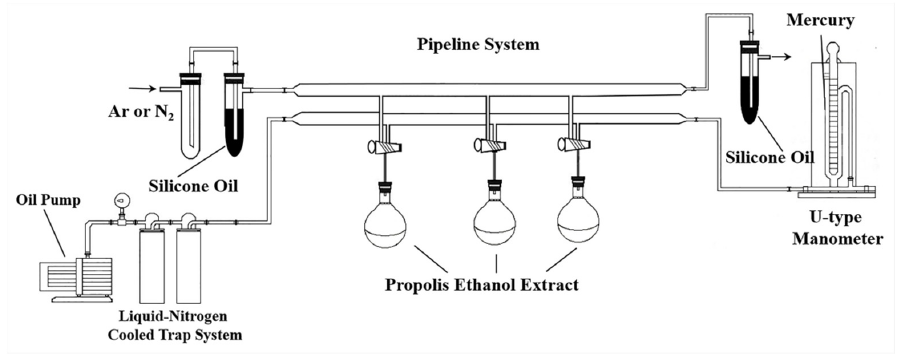
Figure 2. The Schlenk line used to remove water and organic solvent residuals.